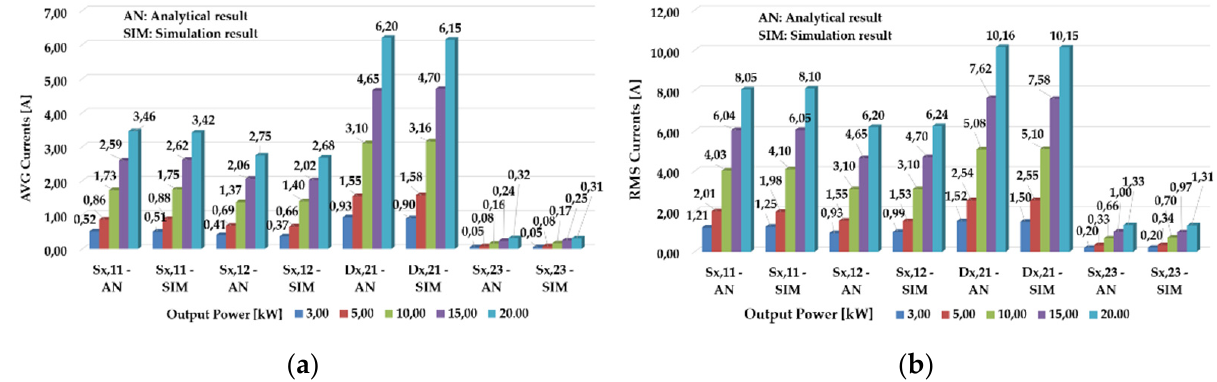
Figure 13. Comparison between the analytical and simulation approaches of the currents flowing in the power semiconductors located in the 3 Φ 5L E-Type MMR: ( a ) AVG; ( b ) RMS.